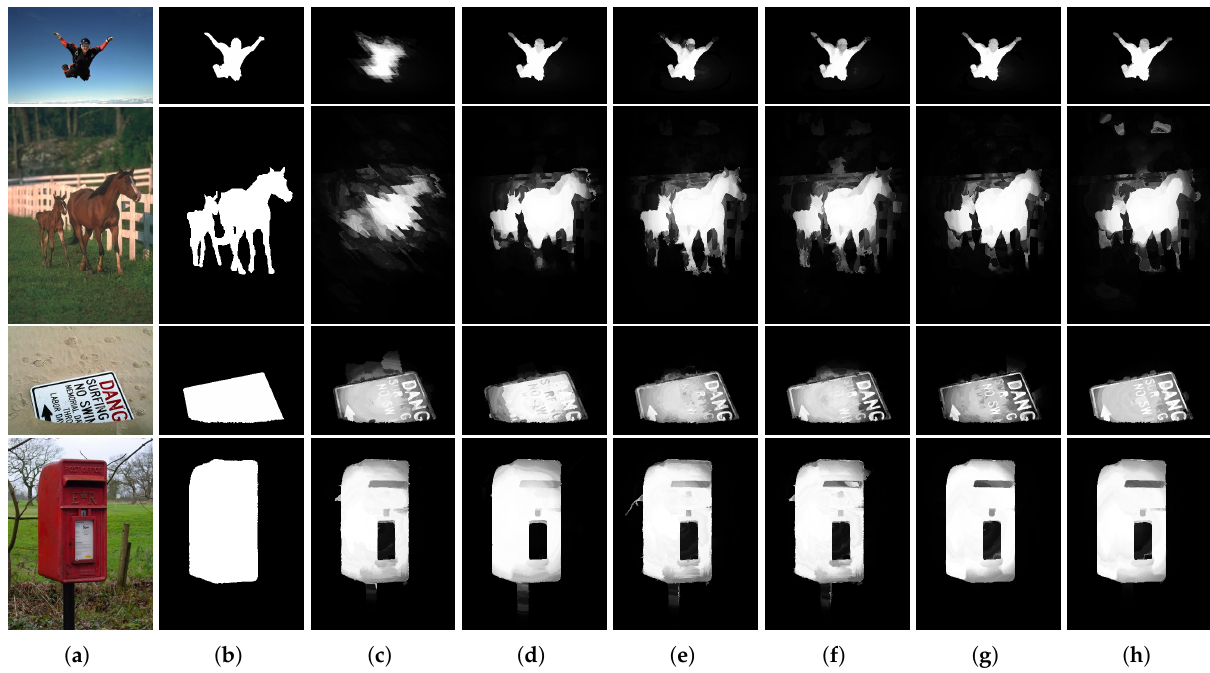
Figure 6. Visual comparison for DSR [46]. ( a ) Input images; ( b ) ground truth; ( c ) results of DSR; ( d ) BF; ( e ) ODOG;